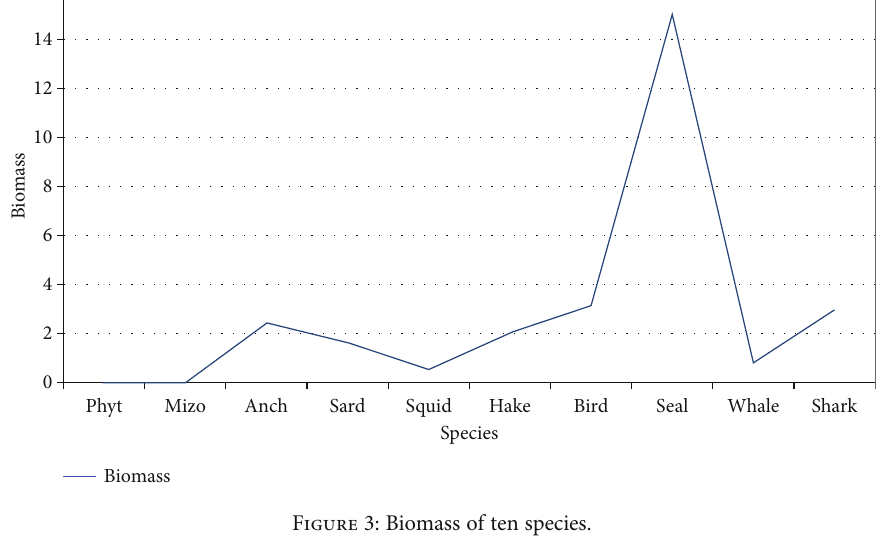
Figure 3: Biomass of ten species.